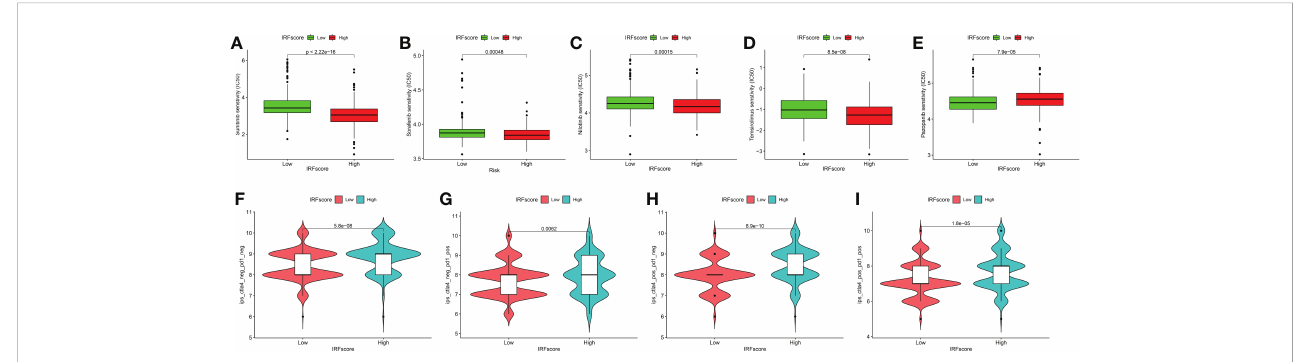
FIGURE 7 IRFscore in the role of ccRCC clinical therapies. (A-E) Box plot showing the sensitivity of patients with high and low IRFscore subgroups to chemotherapy drugs, including sunitinib (A) , sorafenib (B) , nilotinib (C) , temsirolimus (D) and pazopanib (E) . (F-I) The association between IPS and immune checkpoints in ccRCC patients with different